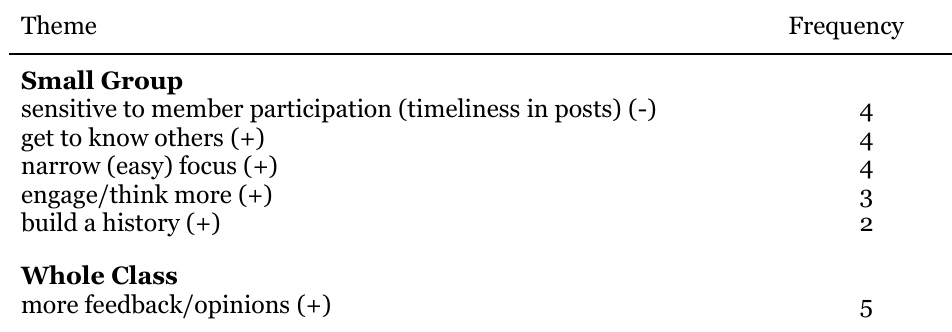
Themes Emerged from Students’ Opinions Regarding Small and Whole Class Discussions